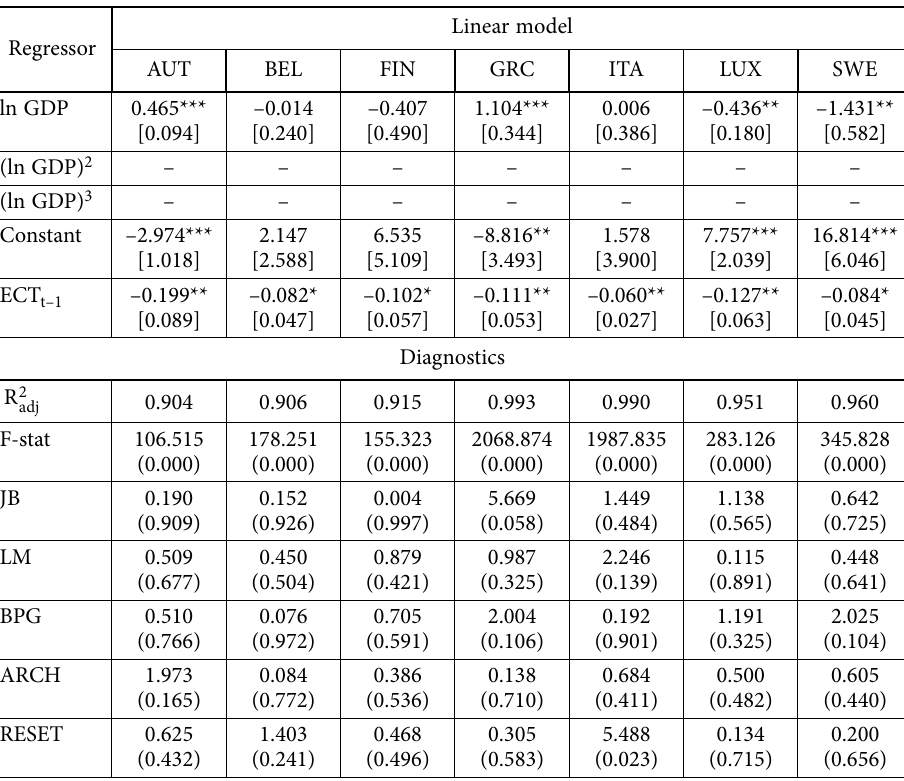
Table 2. Estimated long-run coefficients for the significant ARDL models